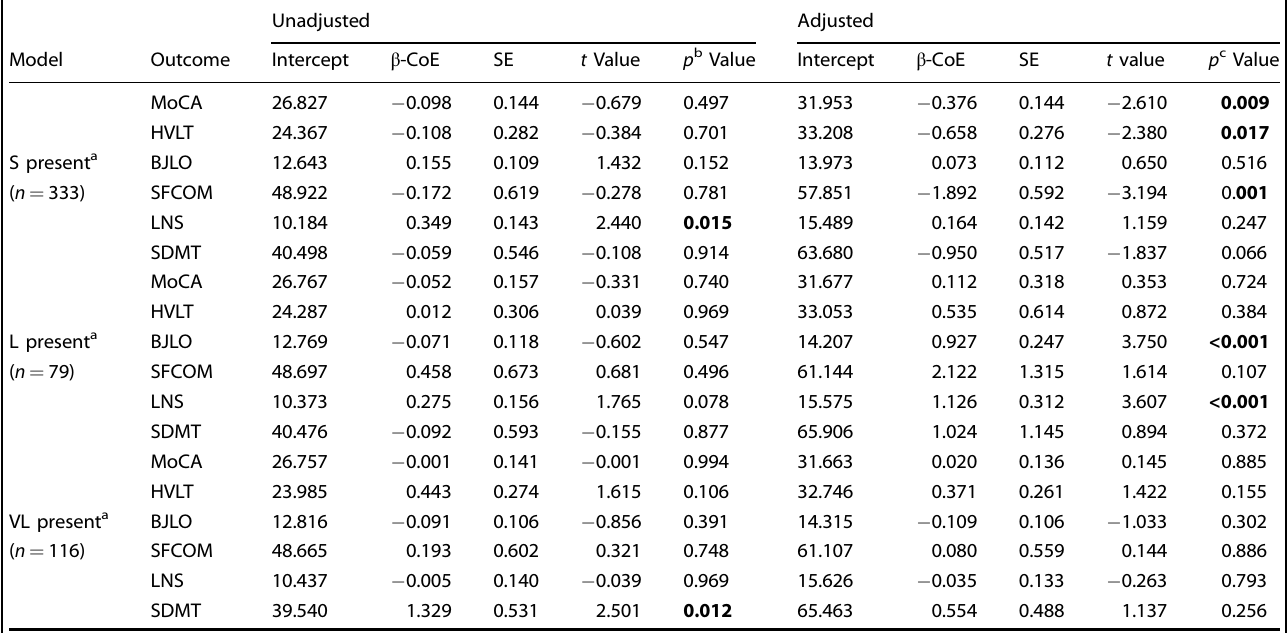
Table 1. Differential effects of TOMM40 ‘ 523 ’ alleles in predicting cognitive performance over time, using unadjusted and adjusted generalised linear mixed models ( n =